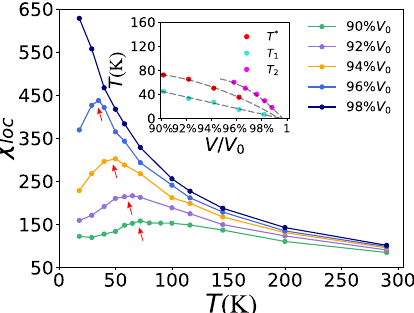
Fig. 4 Temperature dependence of local magnetic susceptibility χ loc for various compressed cell volumes. The inset shows the temperature versus pressure phase diagram. The characteristic temperature T * (marked with the red dots) associated with the formation of Kondo singlet, is corresponding to the maximums of the local magnetic susceptibility marked with red arrows in the main fi gure. Correspondingly, we show the 1/ χ loc in Supplementary Note 3. In comparison, the pressure evolution of T 1 and T 2 from Fig. 3f and Supplementary Fig. 5a are illustrated in the inset as well. The dashed line indicates the gradual suppression trend of T * upon lattice compression. Note that for 98% V 0 Pd-compound, no maximum of fi ed down to 18 χ loc can be identi